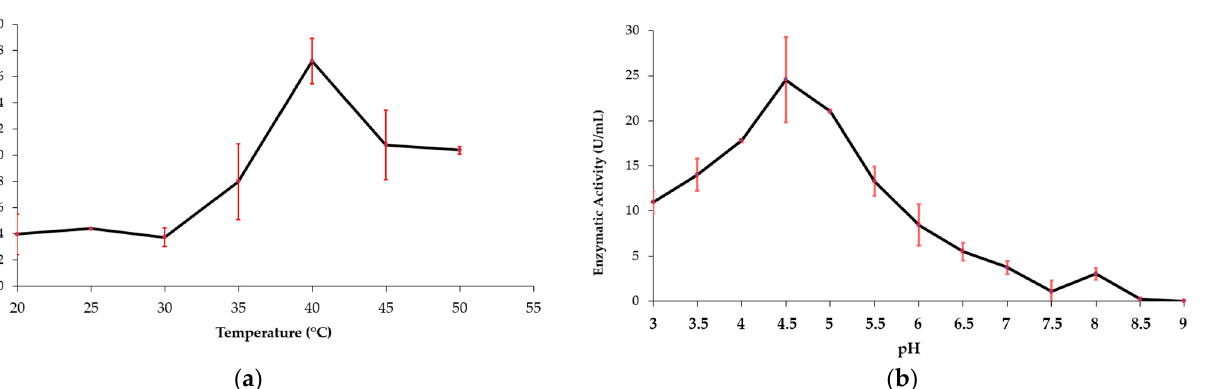
( b ) Figure 7. Per-residue binding free energy decomposition of ( a ) MaBgl3–CBI and ( b ) MaBgl3–BGC